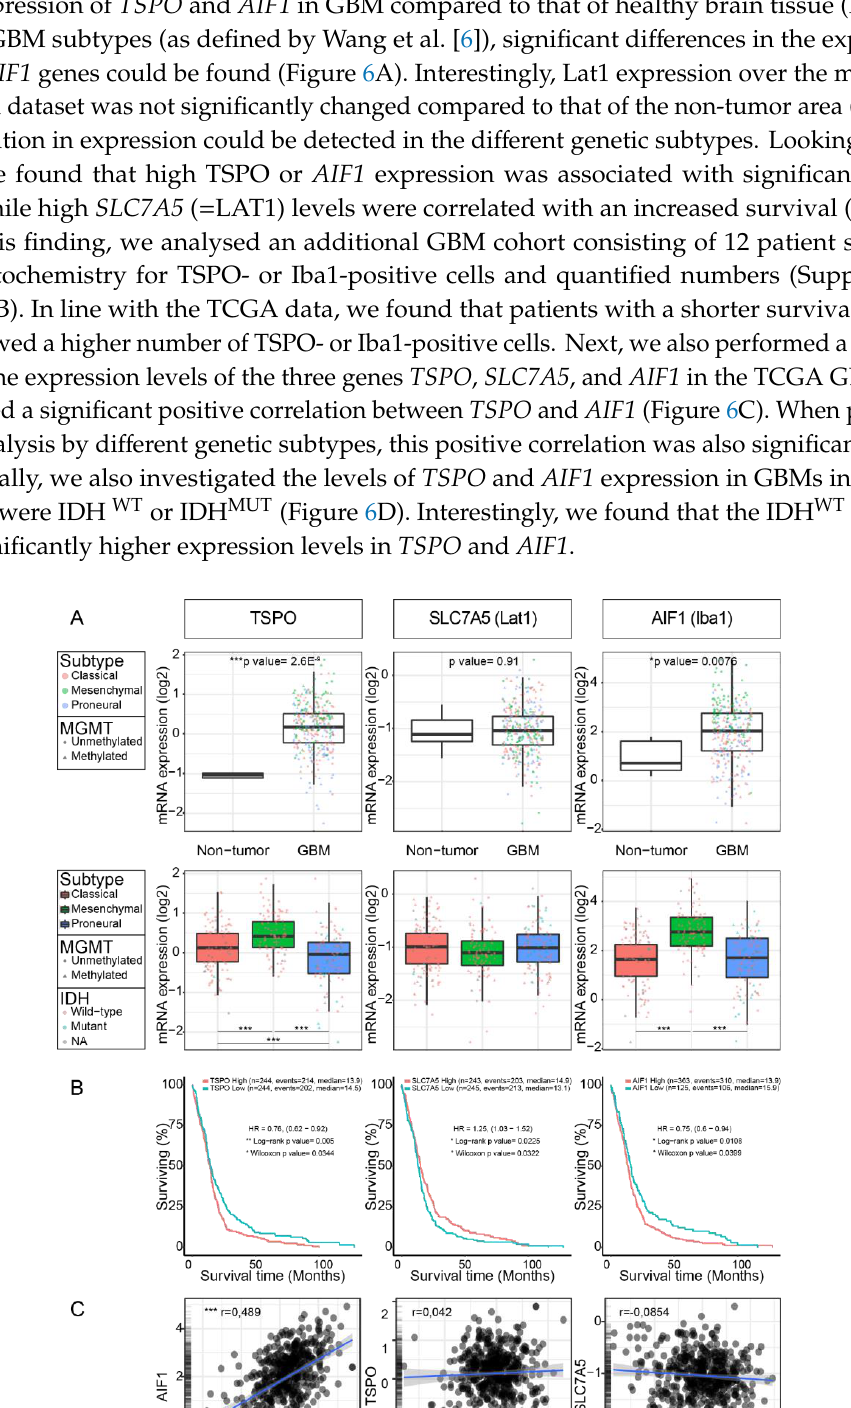
Figure 6. TSPO , solute carrier family 7 member 5 ( SLC7A5 ), and AIF1 expression analysis in a TCGA GBM cohort. Patient GBM samples of the TCGA database were analyzed using GlioVis [29]. ( A ) Gen expression levels in GBM compared to the tumor-free brain showed that expression levels for TSPO and AIF1 were significantly higher in GBM. P - value of Student’s t test is indicated (upper panel). Significant differences between the gene expression of TSPO and AIF1 were also detected for GBM subtypes. Statistical significance ( Tukey’s Honest Significant Difference ) is indicated, *** p < 0.0005 (lower panel). ( B ) Survival of patients with a high or low expression of TSPO , SLC7A5 , or AIF1 was analyzed. High TSPO or AIF1 expression was associated with significantly shorter survival, while high SLC7A5 expression levels were favorable for survival. Patient number indicated in graph. ( C ) A correlation between the genes TSPO , SLC7A5 , and AIF1 was performed. A significant positive correlation between TSPO and AIF1 ( Pearson’s r = 0.489) was observed, while no correlation between the other pairs could be seen. ( D ) Expression levels for TSPO and AIF1 were significantly higher in IDH WT GBM than in IDH MUT . P-value of Student’s t -test is indicated.